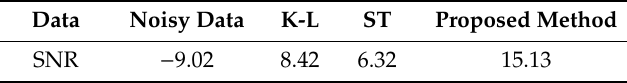
Table 1. Comparison of the signal-to-noise ratio (SNR).